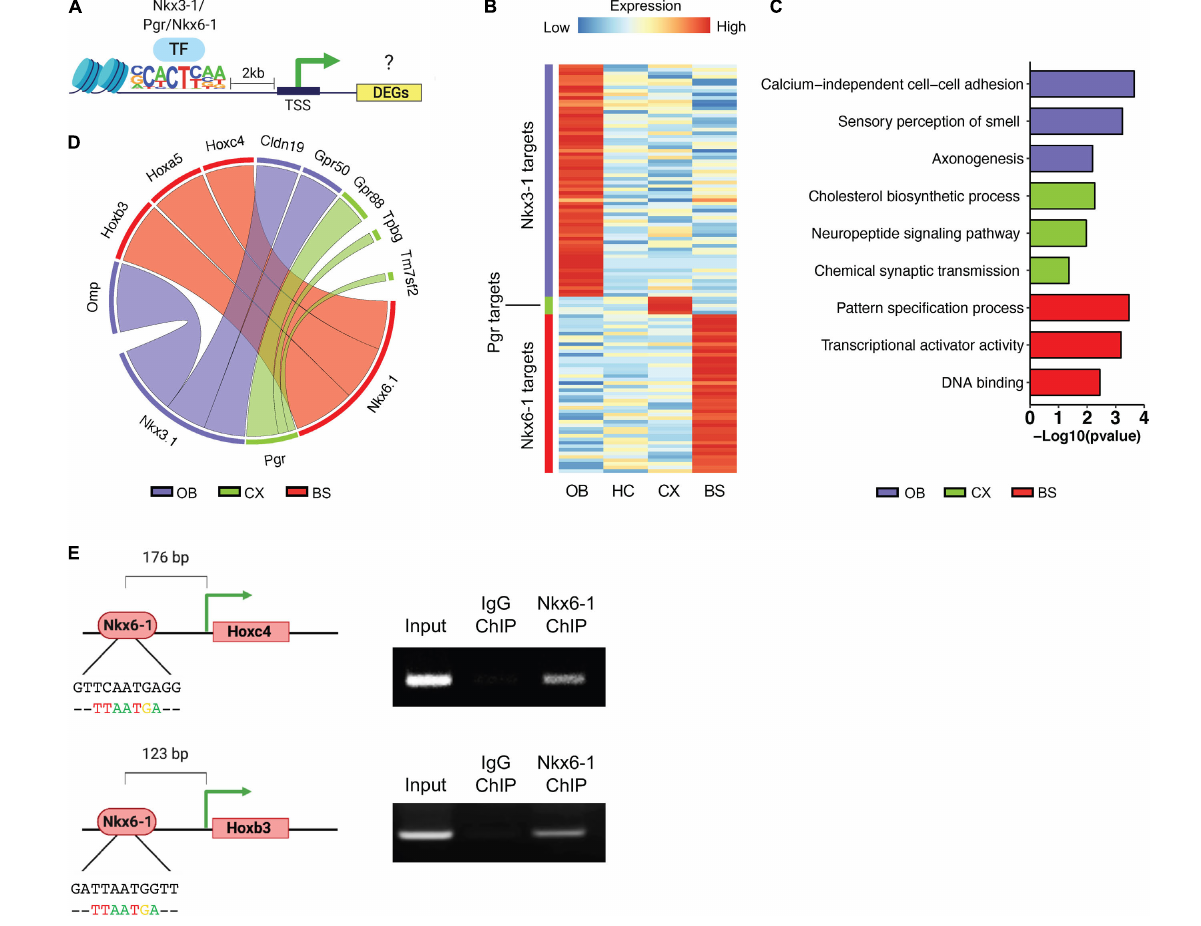
Frontiers in Neuroscience |